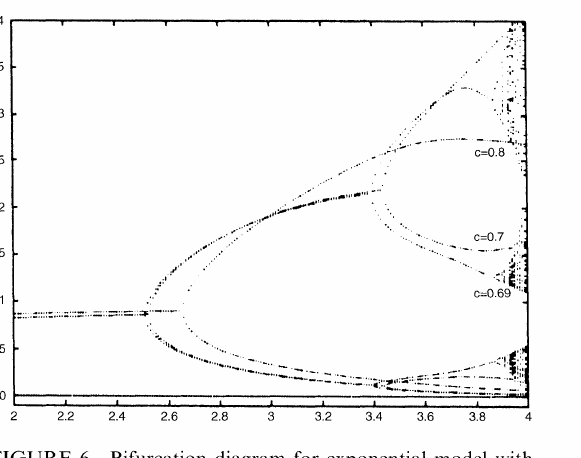
FIGURE 6 Bifurcation diagram for exponential model with cubic migration.